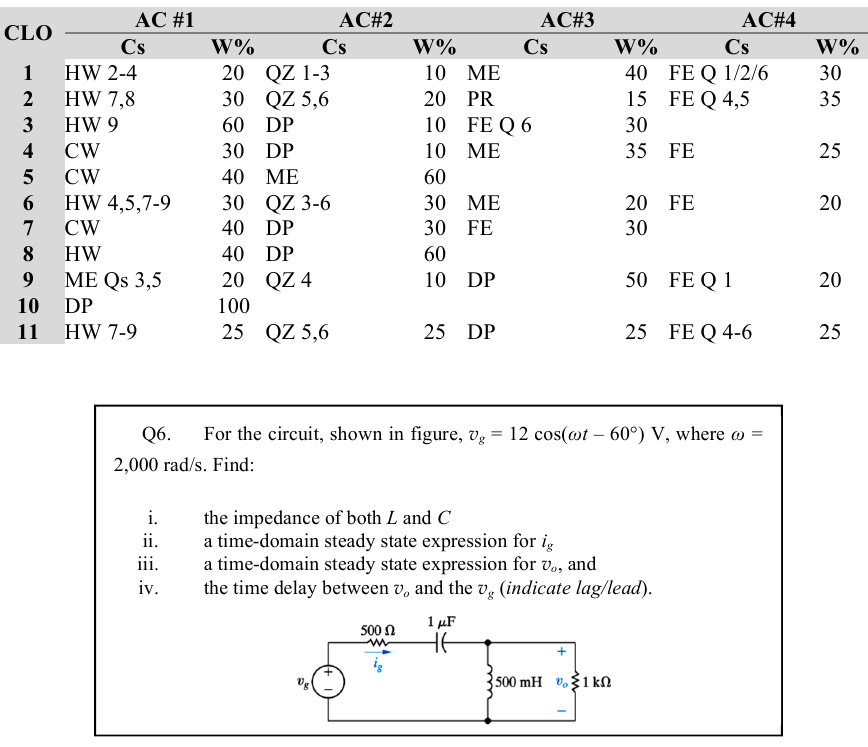
Table 4. Matrix of weighted Assessment and Evaluation Components for all clos of the Electric Circuits (EC) course as presented in Table 3.